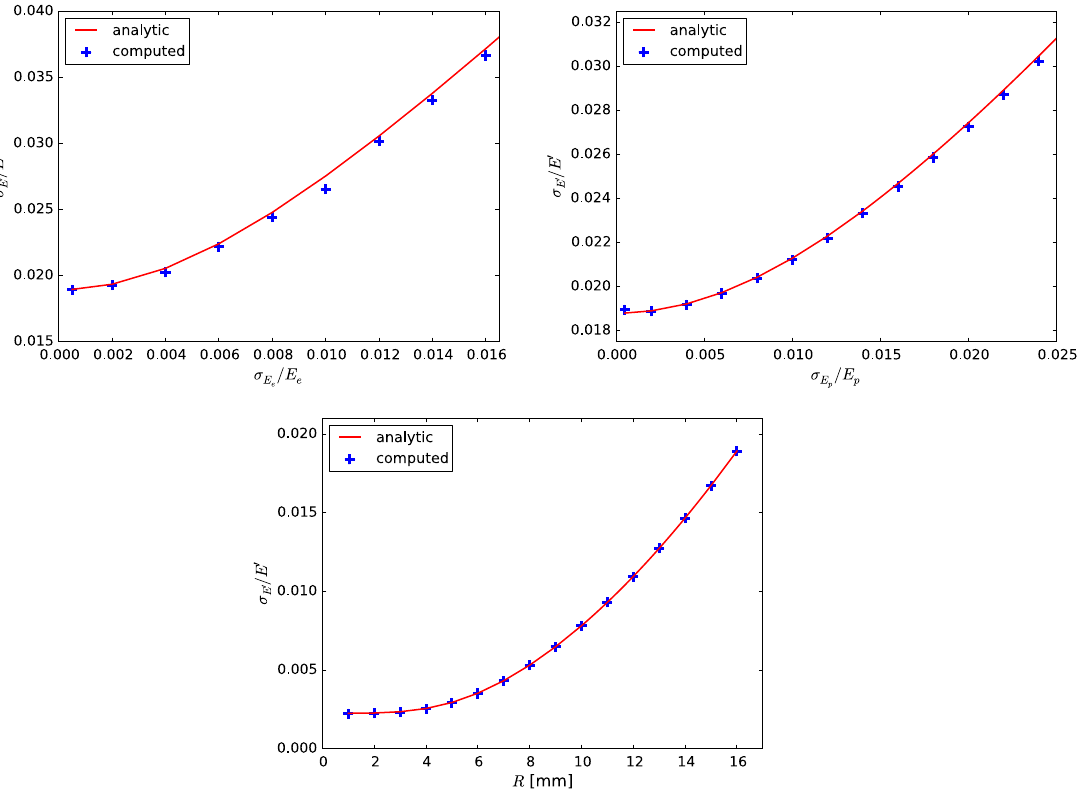
=E σ =E FIG. 5. Relationship between the energy spread of the two colliding beams — σ E e for the electron beam and E p p for the incident e photon beam — and the energy spread of the scattered radiation σ E 0 =E 0 : analytically predicted from Eq. (47) (red curves) and computed with our code (blue crosses). The parameters of the simulation are 500 MeVelectron beam energy with a 800 nm pulsed laser beam, the horizontal emittance ε x ¼ 0 . The laser is collimated by an aperture with radius of 16 mm, placed 60 m downstream from the collision point. Each blue point is generated by averaging 1000 electrons sampling the prescribed distribution. Top left: Energy spread of the electron beam is varied; Gaussian laser pulse width is fixed at σ ¼ 50 , and aperture at 16 mm, placed 60 m downstream from the collision point. Top right: Energy spread of the laser beam is varied by changing its width in physical space; electron beam energy spread =E ¼ 0 and aperture at 16 mm, placed 60 m downstream from the collision point. Bottom: Radius of the aperture is held constant at σ E e e R is varied; electron beam energy spread is held constant at σ =E ¼ 0 , photon beam at σ ¼ 50 . E e e